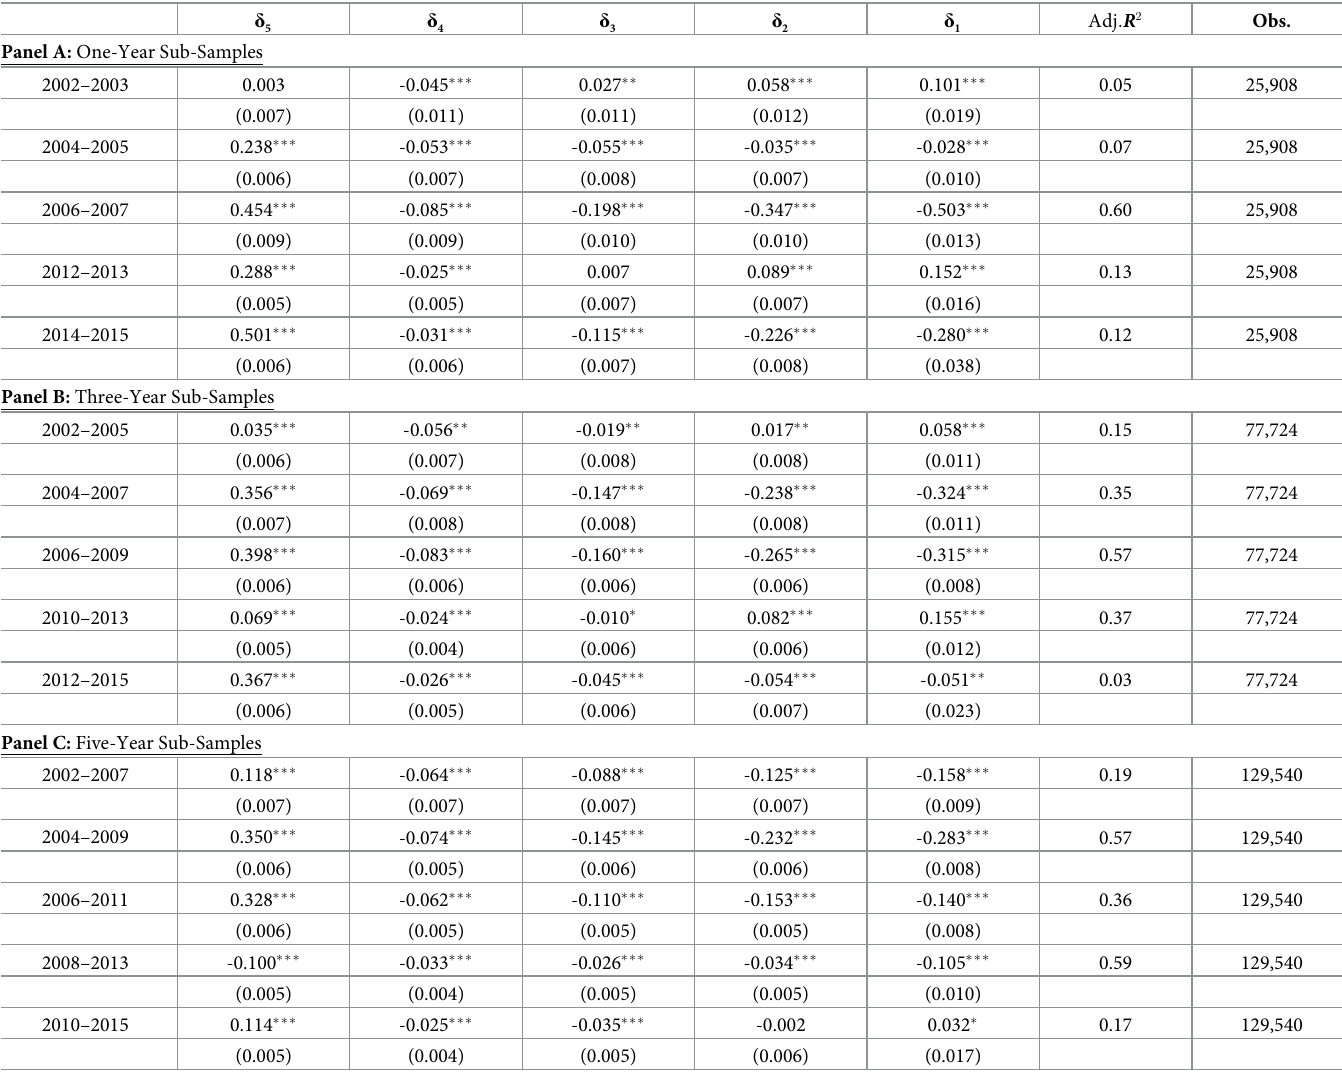
Table 6. Panel regression results derived from ratings based on EU-E ( λ = 0.75) where the Sharpe ratio measures out-of-sample performance. δ